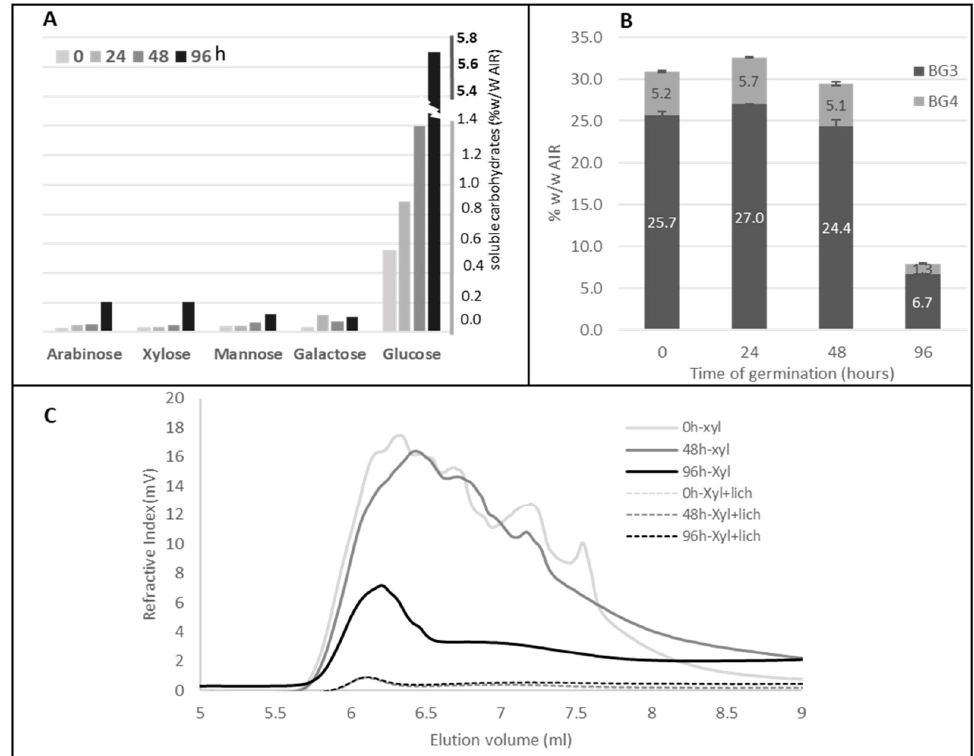
Figure 2. Biochemical analysis of germinated grains ( A ). Composition of soluble sugars obtained from Brachypodium wild type grains during the germination process (hours counted after the imbibition step). ( B ). HPAEC analysis of tri- and tetramers (BG3 and BG4, respectively) released from MLG after lichenase treatment of the AIR of germinated WT grains. ( C ). HPSEC analysis of hemicelluloses extracted by alkaline treatment from grain at various germination times and after xylanase digestion to detect the MLG profile, or xylanase + lichenase digestion to degrade both arabinoxylans and MLG.